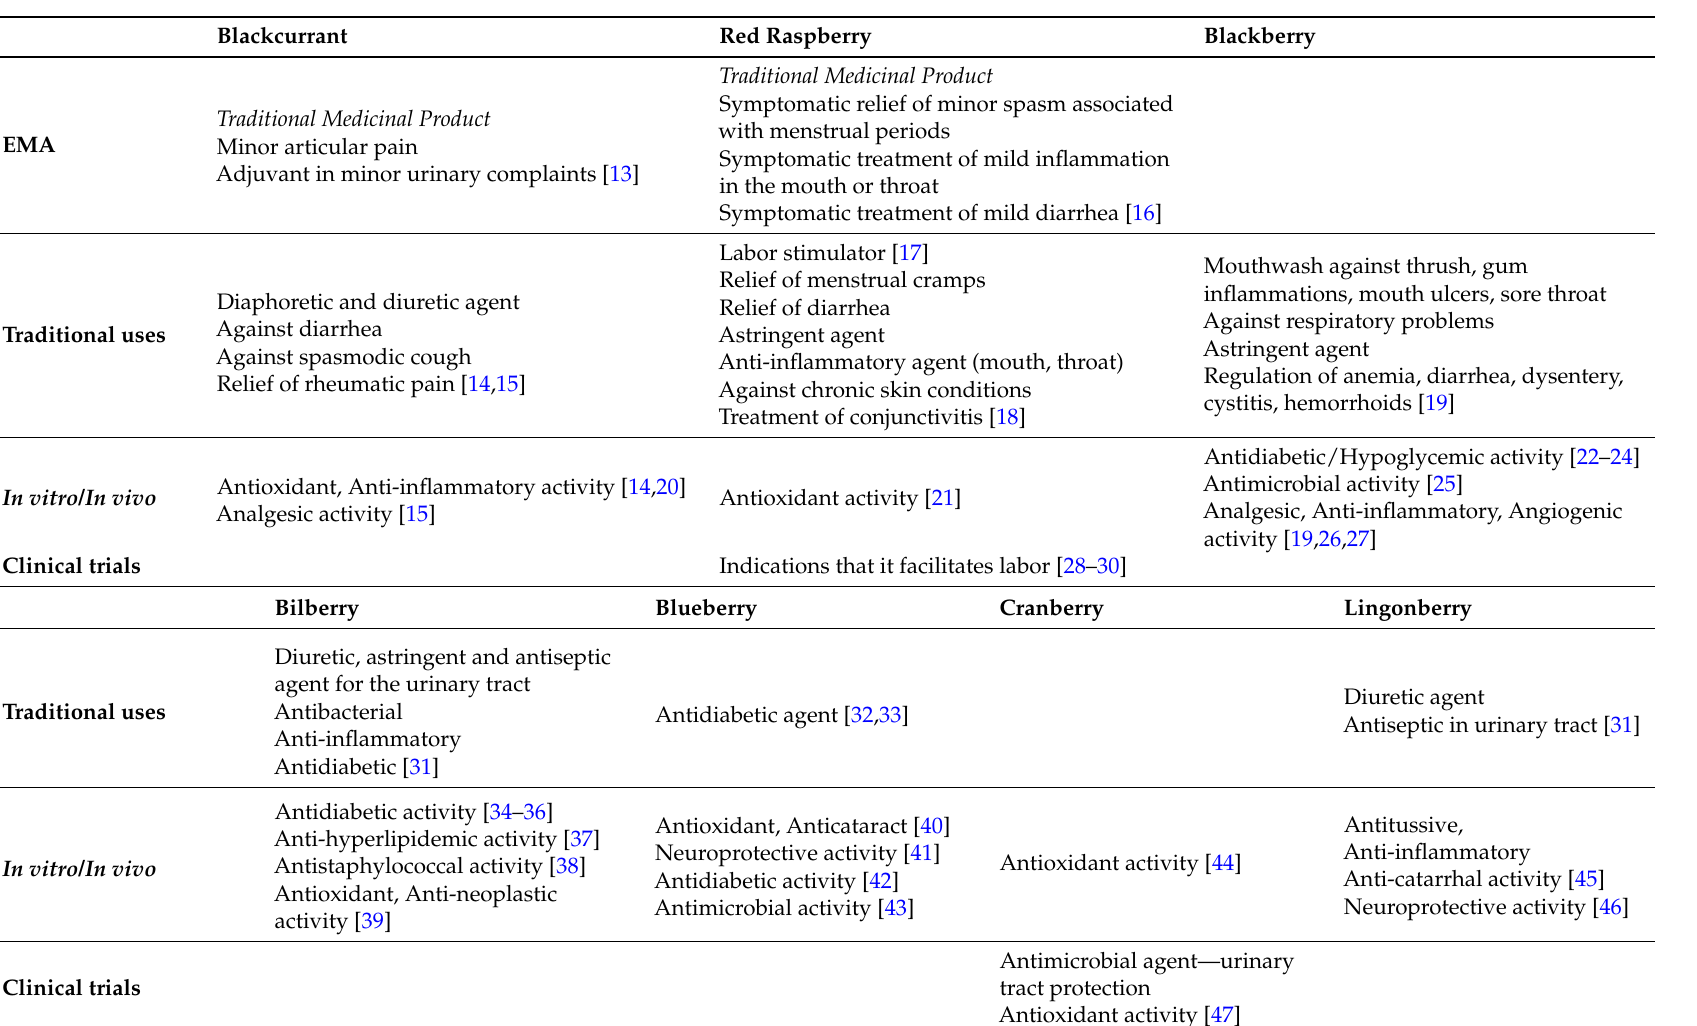
Table 2. Medicinal uses and biological properties of berry